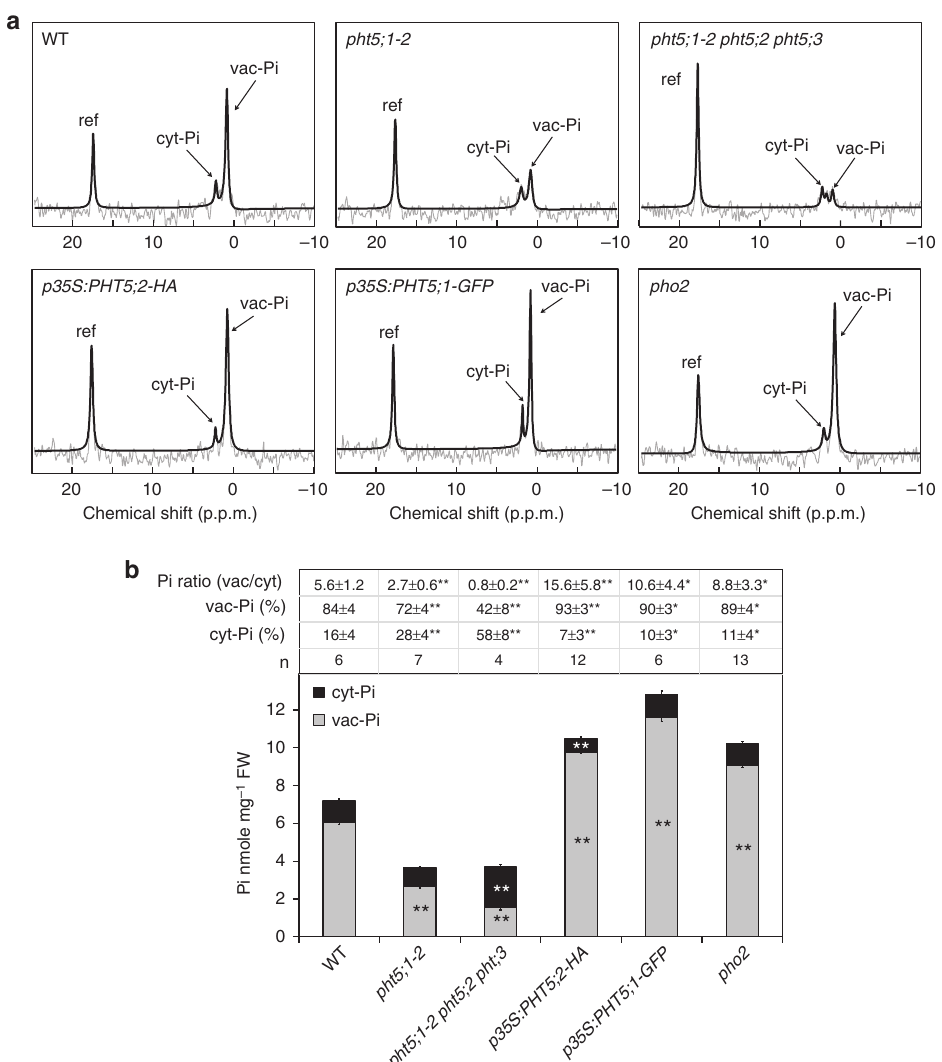
Figure 4 | PHT5 proteins regulate the storage of vac-Pi and cyt-Pi homeostasis. 31 P-MRS analysis of vac-Pi and cyt-Pi ( a ), Pi distribution between the vacuole and the cytoplasm, and the calculated vac-Pi and cyt-Pi levels ( b ) of WT, pht5;1-2 , pht5;1-2 pht5;2 pht5;3 , p35S:PHT5;2-HA, p35S:PHT5;1-GFP and pho2 seedlings grown under Pi-sufficient conditions. ref, methylene diphosphonate (MDP). Asterisks indicate a significant difference compared with WT, * P o 0.05 and ** P o 0.01, Student’s t -test, ± s.d.; error bar, s.e. The numbers of biological replicates ( n ) are indicated in b . Results were combined from three to six independent